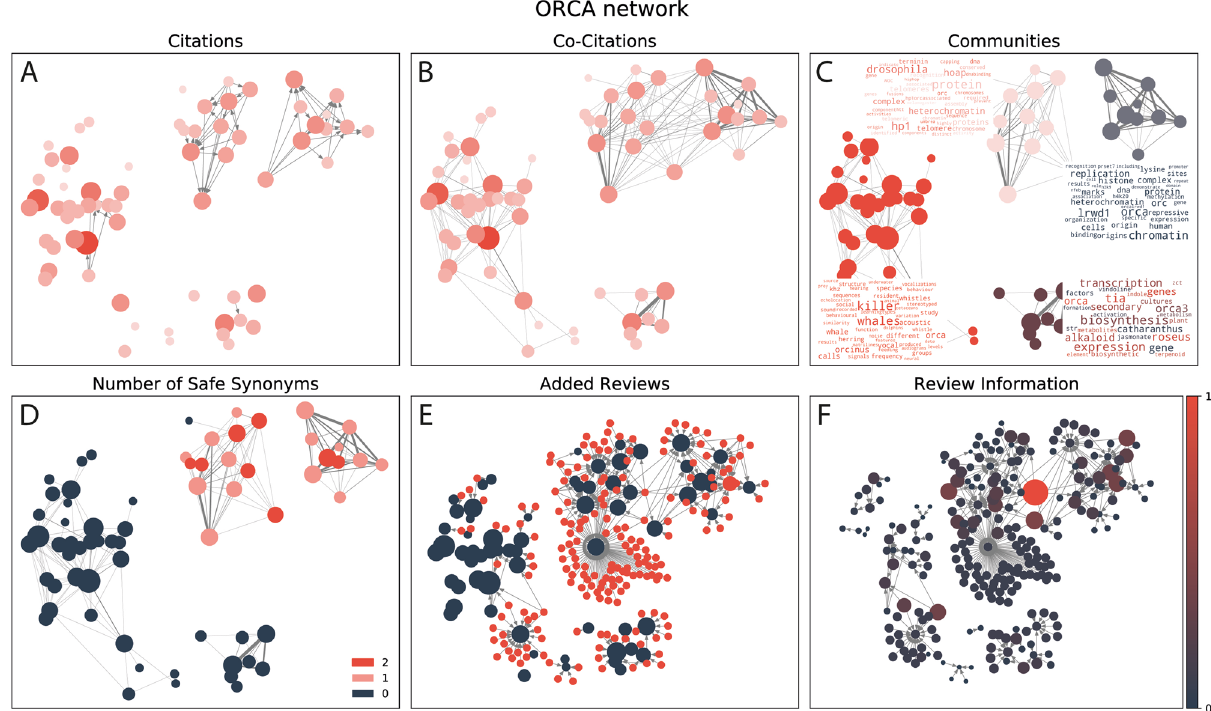
Figure 2. Disambiguation pipeline. (A) Citation network for a subset of PubMed IDs mentioning any of the gene synonyms of the gene symbol LRWD1, including ORCA. (B) Co-citation network of the same subset of PubMed IDs as in (A) . (C) Communities for the co-citation graph obtained after using iGraphs fast greedy algorithm: killer whale community, orca plant cluster, LRWD1 in drosophila and LRWD1 in heterochromatin. (D) Number of safe synonyms per PubMed ID in title or abstract in the same co-citation network. (E) Citation network with reviews citing any of the PubMed IDs. (E) Review information as defined by the recommender system scaled from 0 to 1.